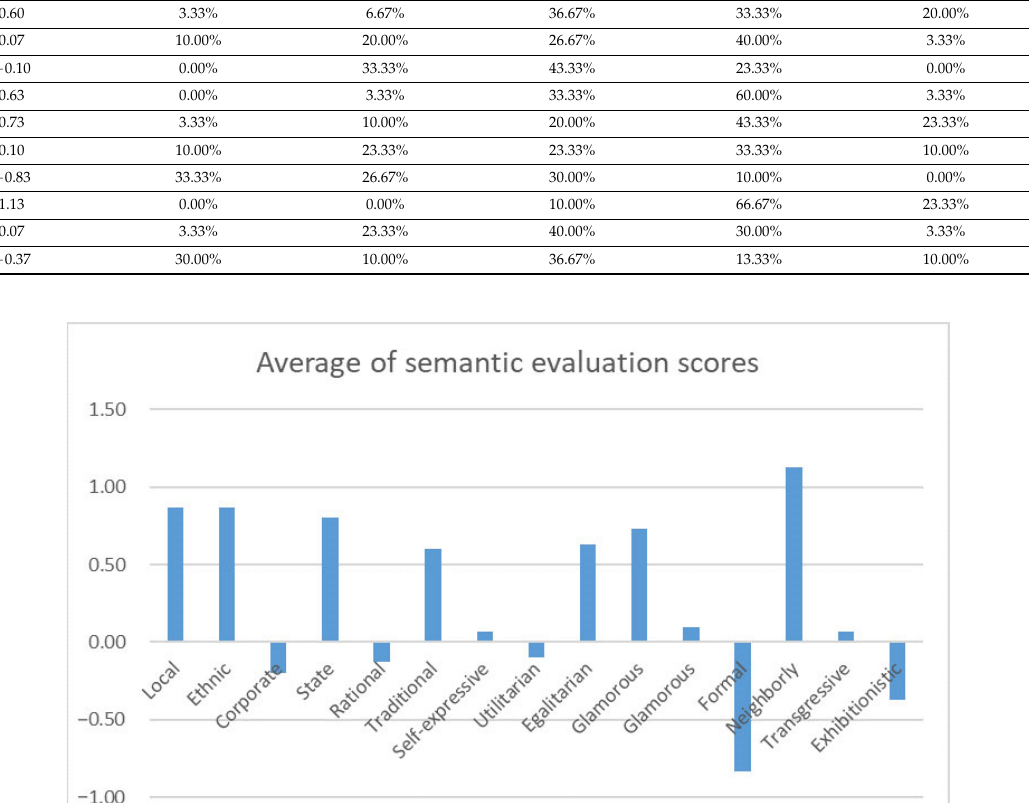
Figure 4. Mean semantic evaluation graph.